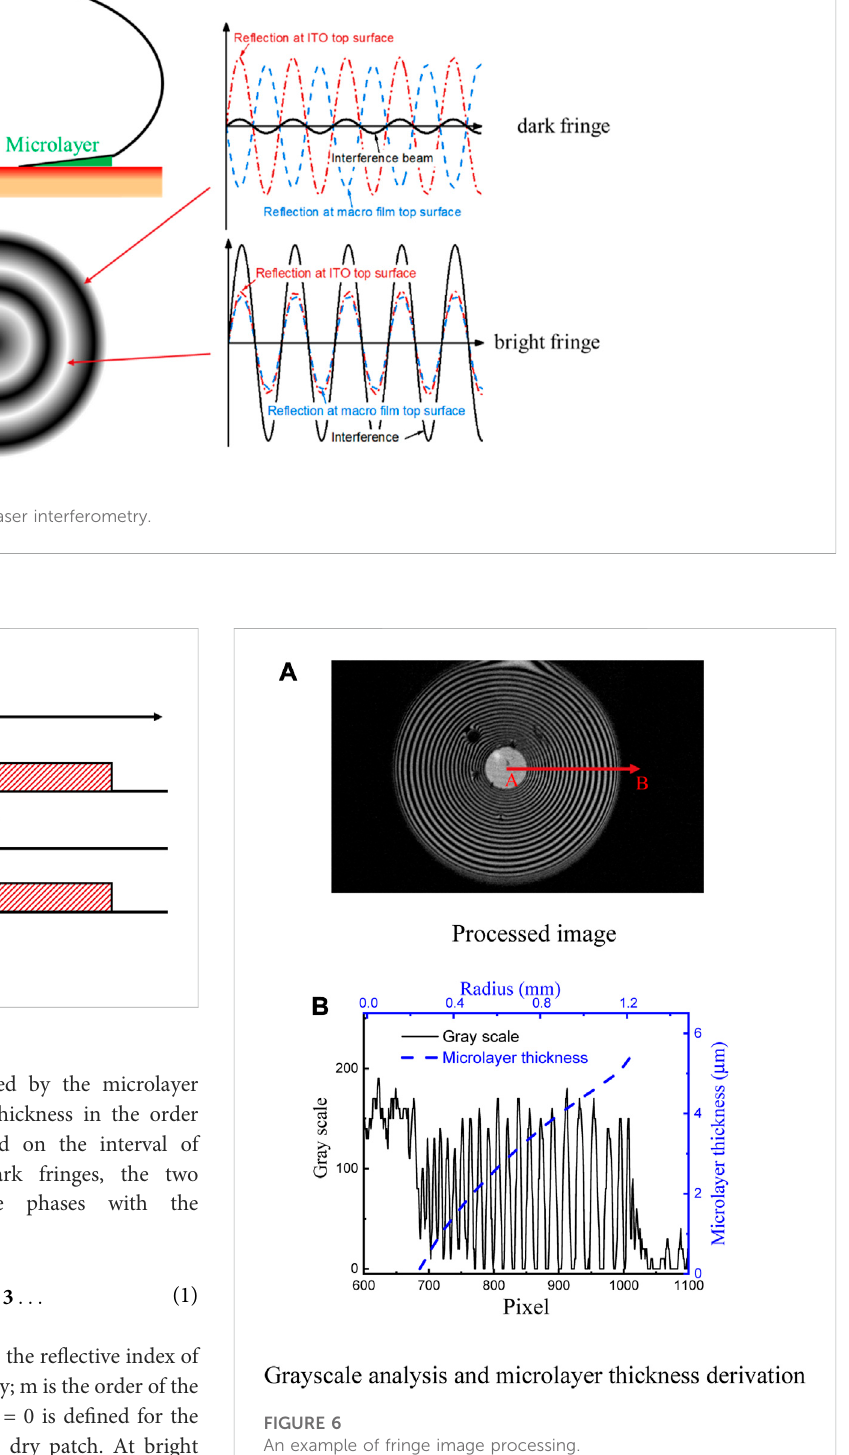
FIGURE 6 An example of fringe image